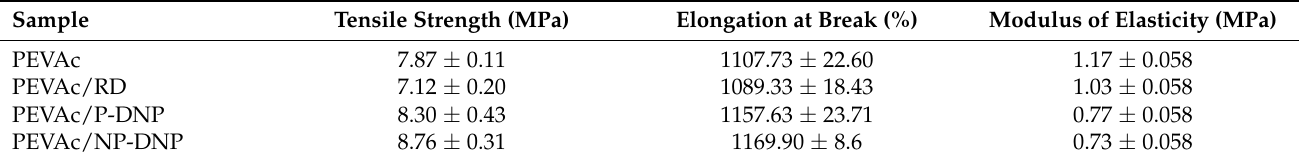
Figure 12. Images of ( a ) PEVAc, ( b ) PEVAc/RD, ( c ) PEVAc/DNP, and ( d ) PEVAc/NP-DNP.